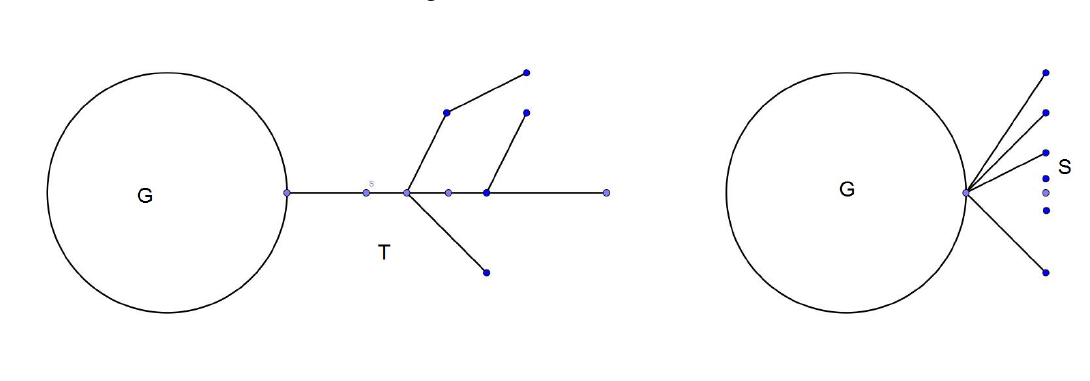
Figure 3. GT and GS